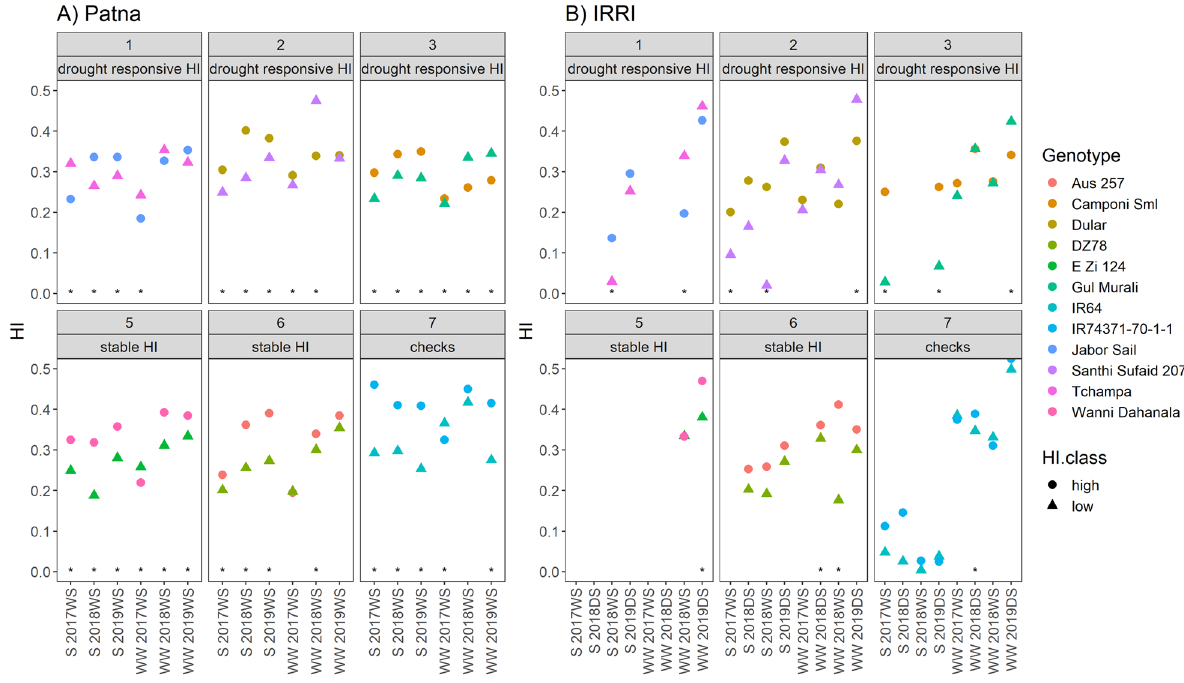
Fig. 2 Harvest index across experiments under drought stress (S) and well-watered (WW) conditions at A Patna and B IRRI. The boxes at the top of each panel indicate the pair ID as well as the classification of the HI response as stable across treatments (stable HI) or more prevalent under drought stress (drought-responsive HI). Significant differences between genotypes within a pair (based on different letter groups in according to Tukey’s test) are indicated by *. WS: wet season, DS: dry season. The treatment, year, and season of each experiment are shown on the